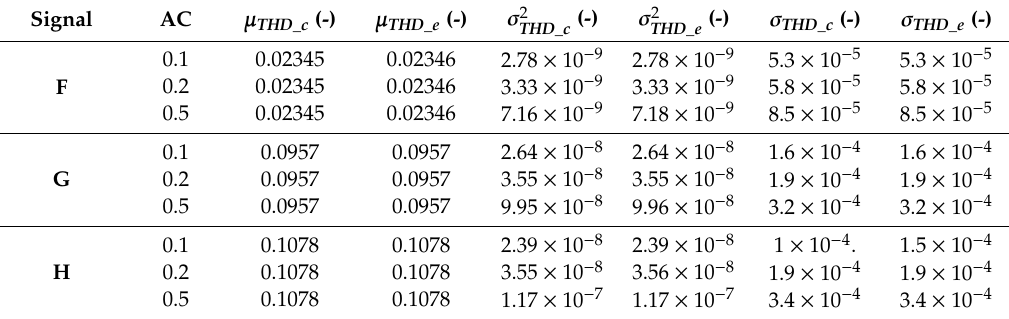
Table 6. Results of the test vs. harmonic accuracy class limit at 0.5%.